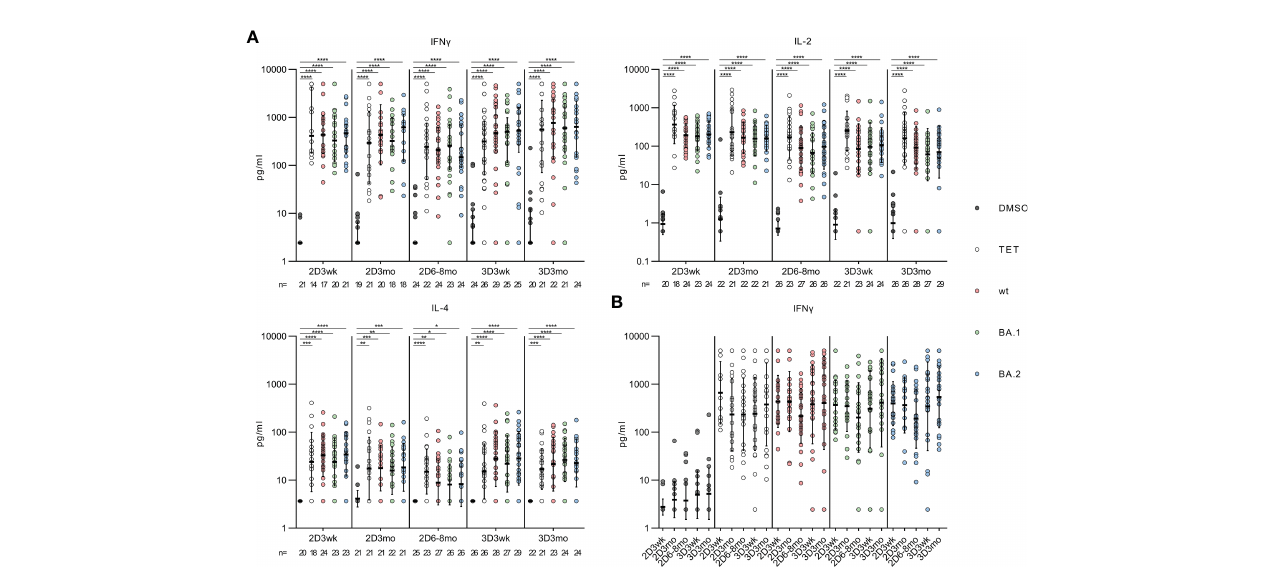
FIGURE 5 Effector cytokines IFN- g , IL-2 and IL-4 secreted by the SARS-CoV-2 spike protein stimulated PBMCs. (A) , Secreted cytokines (IFN- g , IL-2 and IL-4) were analyzed from the supernant of DMSO, tetanus toxoid (TET), and SARS-CoV-2 (wt, BA.1, and BA.2) spike protein peptide pool -stimulated PBMCs collected from 32 HCWs. (B) , Comparison of the secreted IFN- g levels at indicated time points. The data are represented as geometric means with geometric SDs. The statistical signi fi cances were determined with the Kruskal-Wallis test followed by Dunn ’ s multiple comparisons test. *p<0.05;